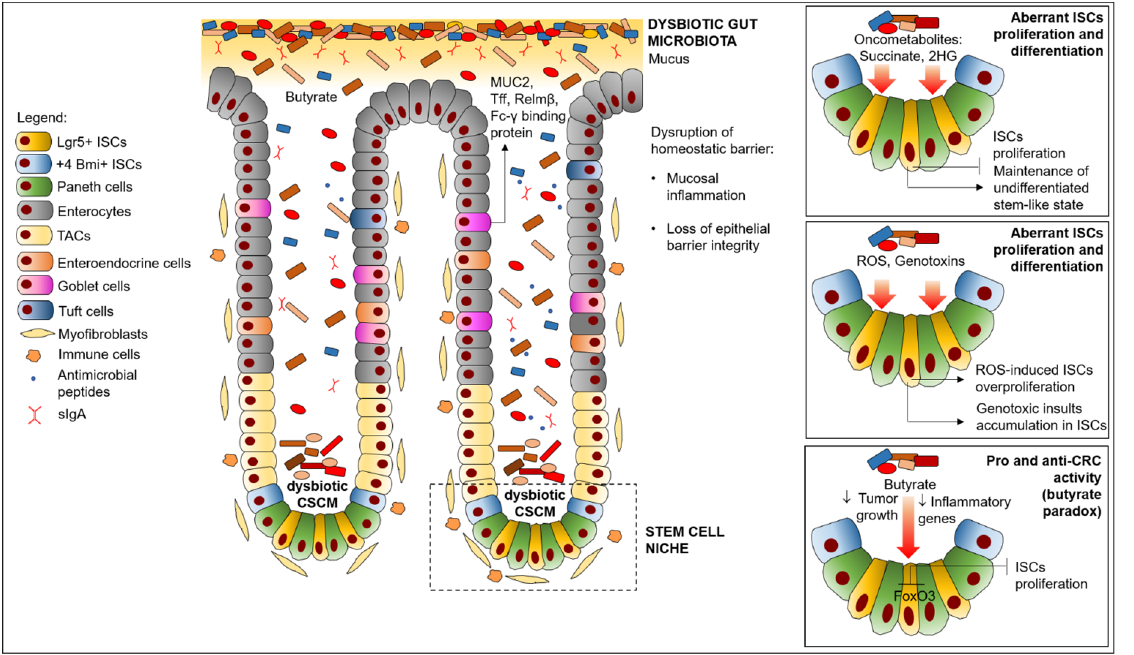
Figure 2. Effects of dysbiosis on ISC niche impairment in CRC. Abbreviations: CSCM, crypt-specific core microbiota; ISCs, intestinal stem cells; ROS, Reactive Oxygen Species, sIgA, secreted immunoglobulin A; TAC, transient-amplifying cells; 2HG, L-2-hydroxyglutarate.